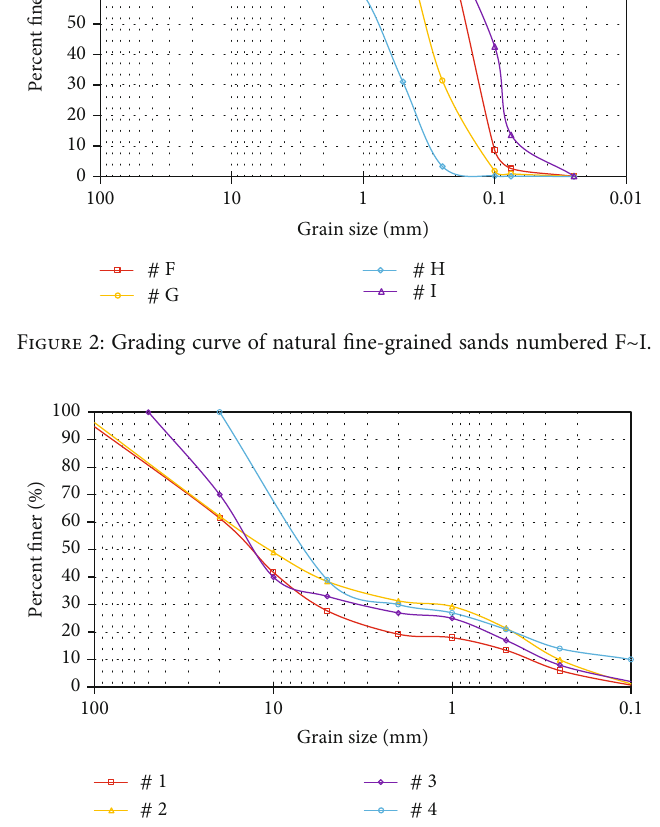
Figure 3: Grading curve of laboratory-made sandy gravels numbered 1 ~